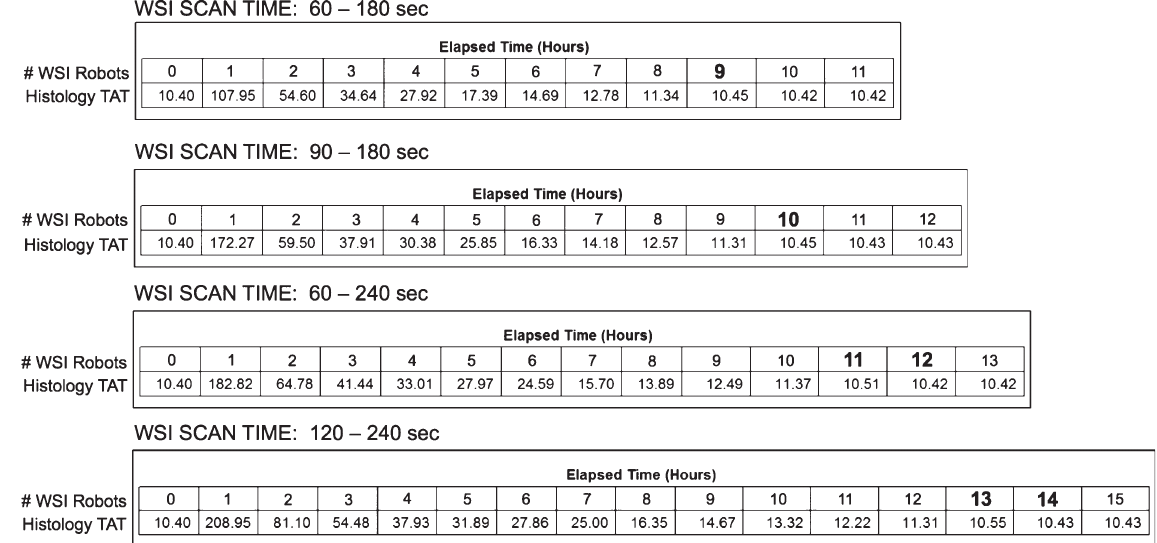
Fig. 6. Number of WSI robots needed to maintain the current workflow in a high-volume (2400 slides/day) clinical histology laboratory. Bolded numbers in the above charts denote the point at which additional WSI robots have little to no effect on histology lab turn-around-time